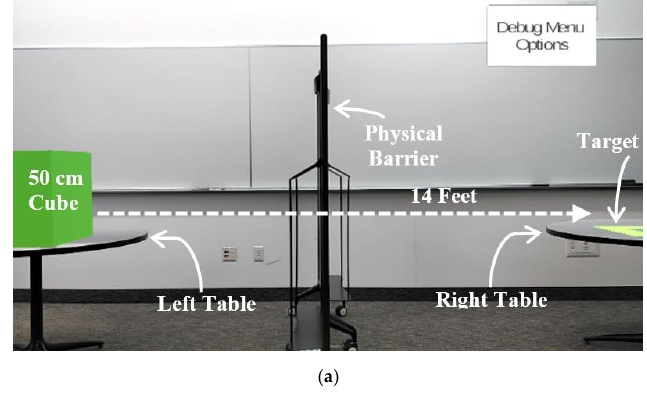
Figure 3. Small-scale tests. ( a ) Test 1 : 2D translation; ( b ) Test 2: 3D translation; ( c ) Test 3 : 3D translation and